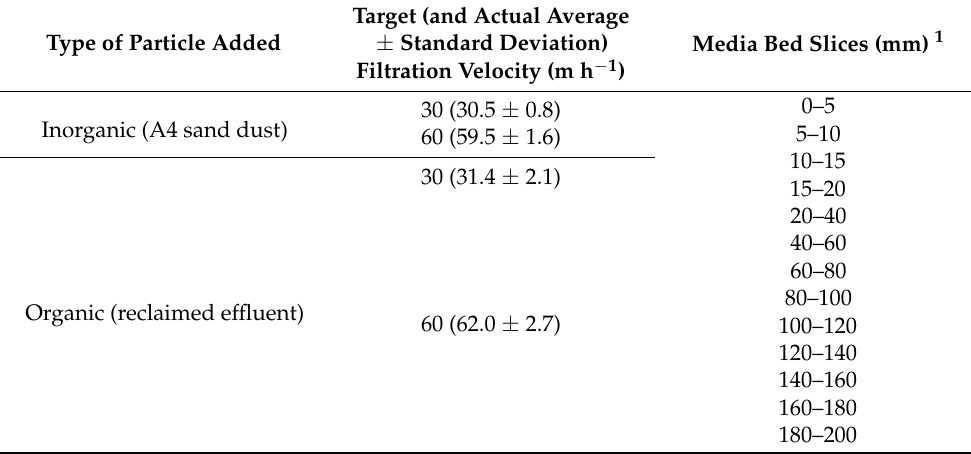
Table 1. Factors included in the present